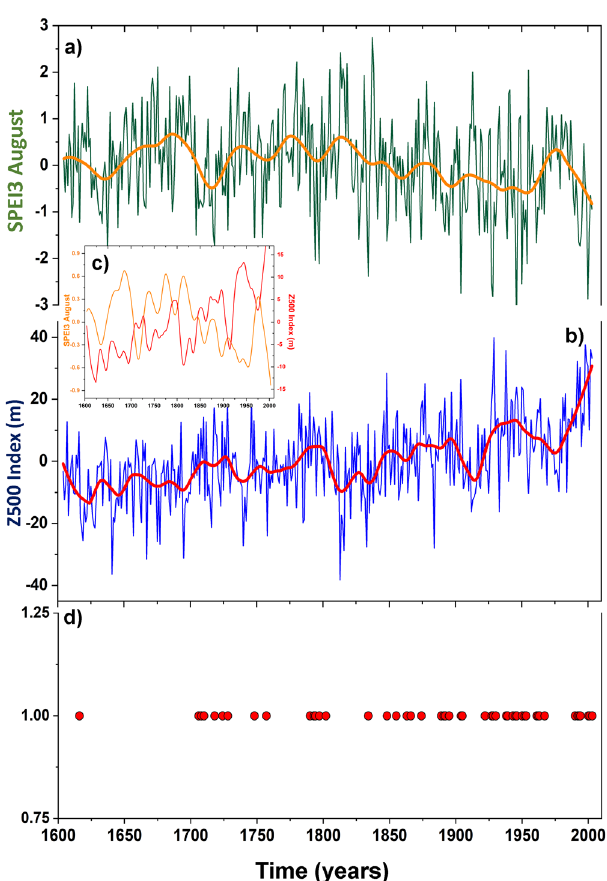
Fig. 6 Drought reconstruction and large-scale drivers. a Reconstructed SPEI 3 (green line) and 31-year running mean (orange line); b summer (JJA) Z500 time series averaged over the stable region: 13.5°E – 35.0°E, 30°N – 52°N (blue line) and 31-year running mean (red line). c The direct comparison between the 31-year running mean for SPEI 3 reconstruction (orange line) and for summer Z500 time series (red line) and d Occurrence of positive Z500 anomalies and dry events (Z500 75 /SPEI3 25 ). Z500 75 / SPEI3 25 indicates that we took into account the common years when the Z500 anomalies were higher than the 75th percentile and SPEI3 was smaller that the 25th